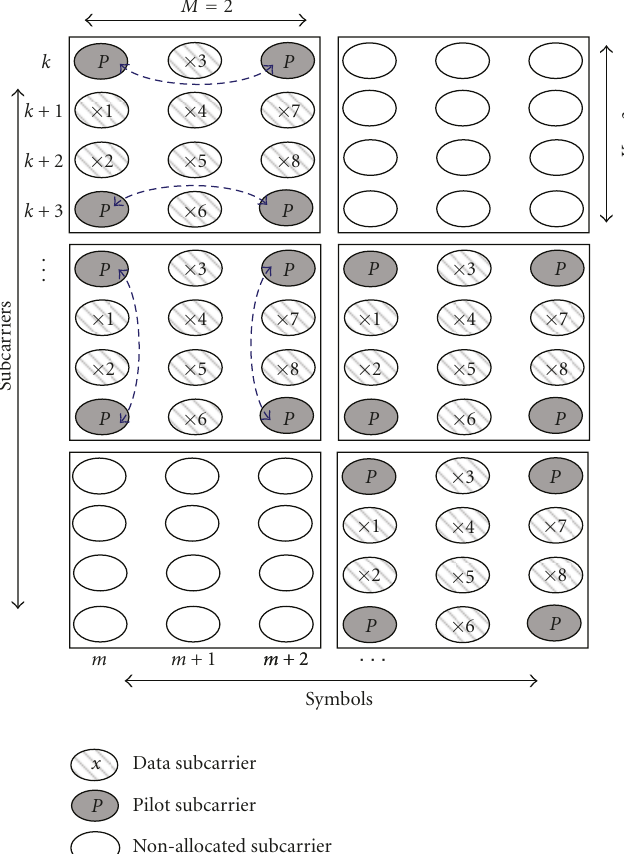
Figure 2: 6 blocks in a WiMAX UL-PUSC system, where each block is a 4 × 3 tile, that is, K = 3 and M = 2 . Correlations for obtaining (cid:13) ξ are illustrated in the first block, while the correlations for obtaining (cid:13) τ are illustrated in the second block.